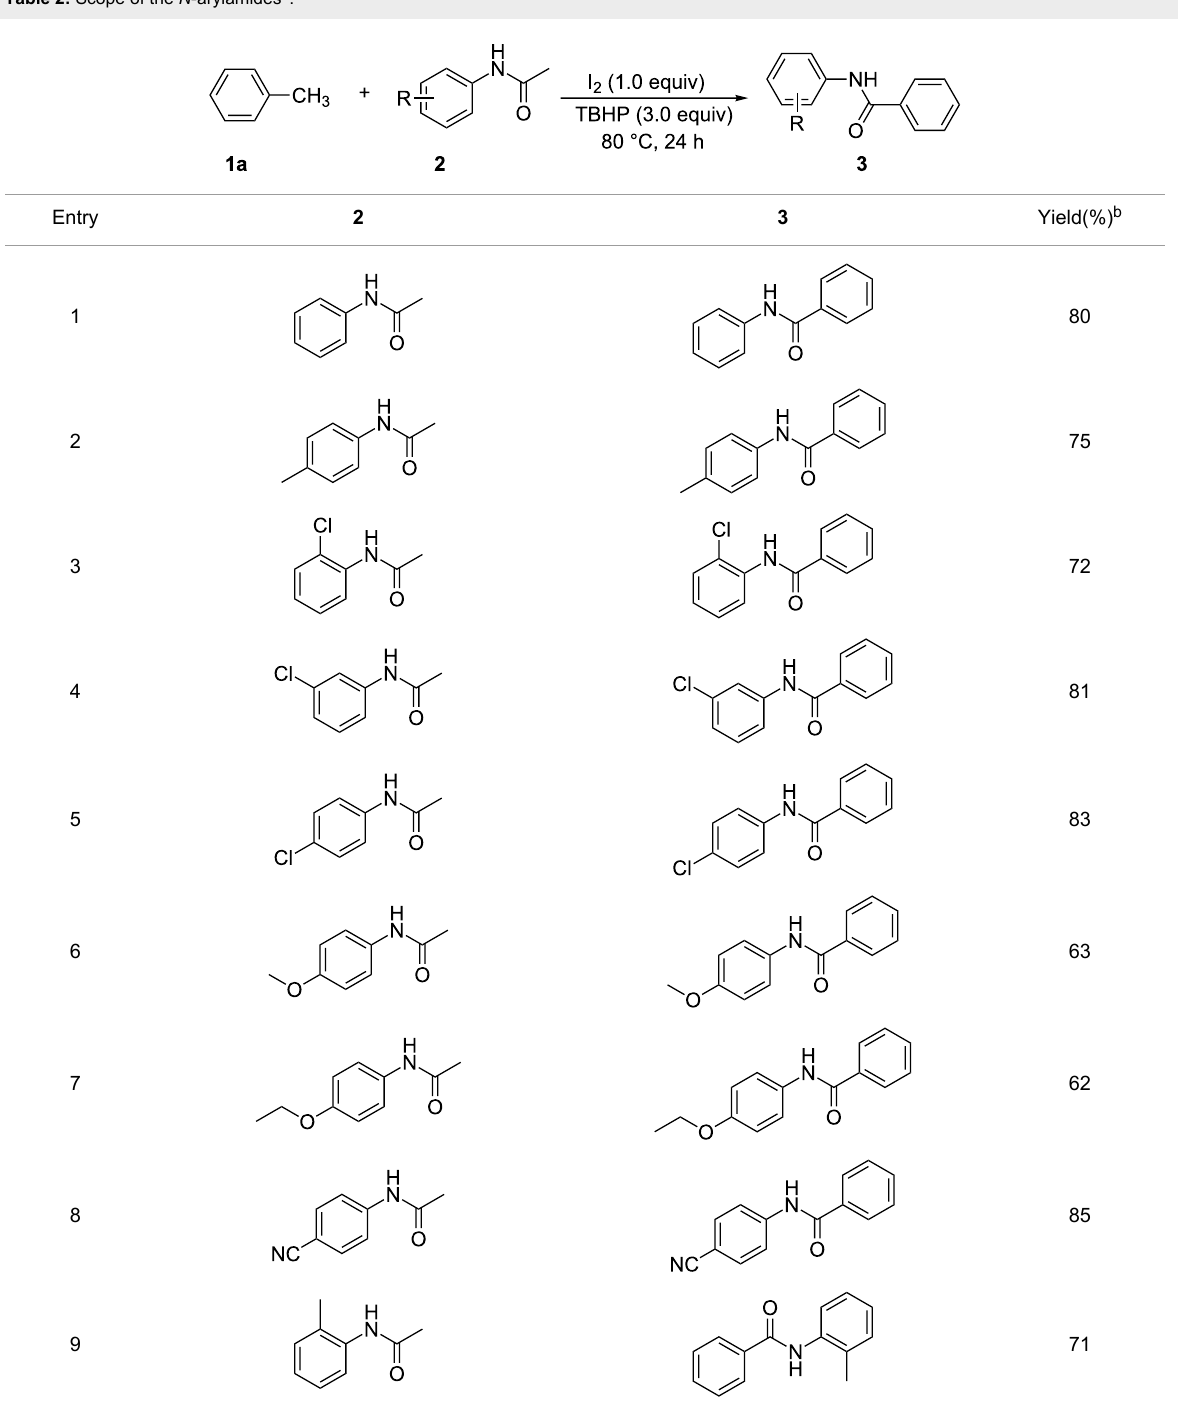
Table 2: Scope of the N -arylamides a